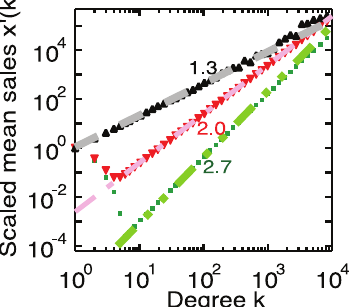
Figure 4. The mean of sales as a function of degree, x ( k ) , for Model-2. We plot the scaled values [ x ’ ( k ) ~ x ( k ) = x (1) ]. The black triangles indicate the network for c ~{ 0 : 7 , the red nablas for c ~ 0 : 0 , the green squares for c ~ 0 : 7 , the black dashed line is proportional to k 2 ~ k 1 : 3 , the red dash-dotted line is proportional to k 2 : 0 and